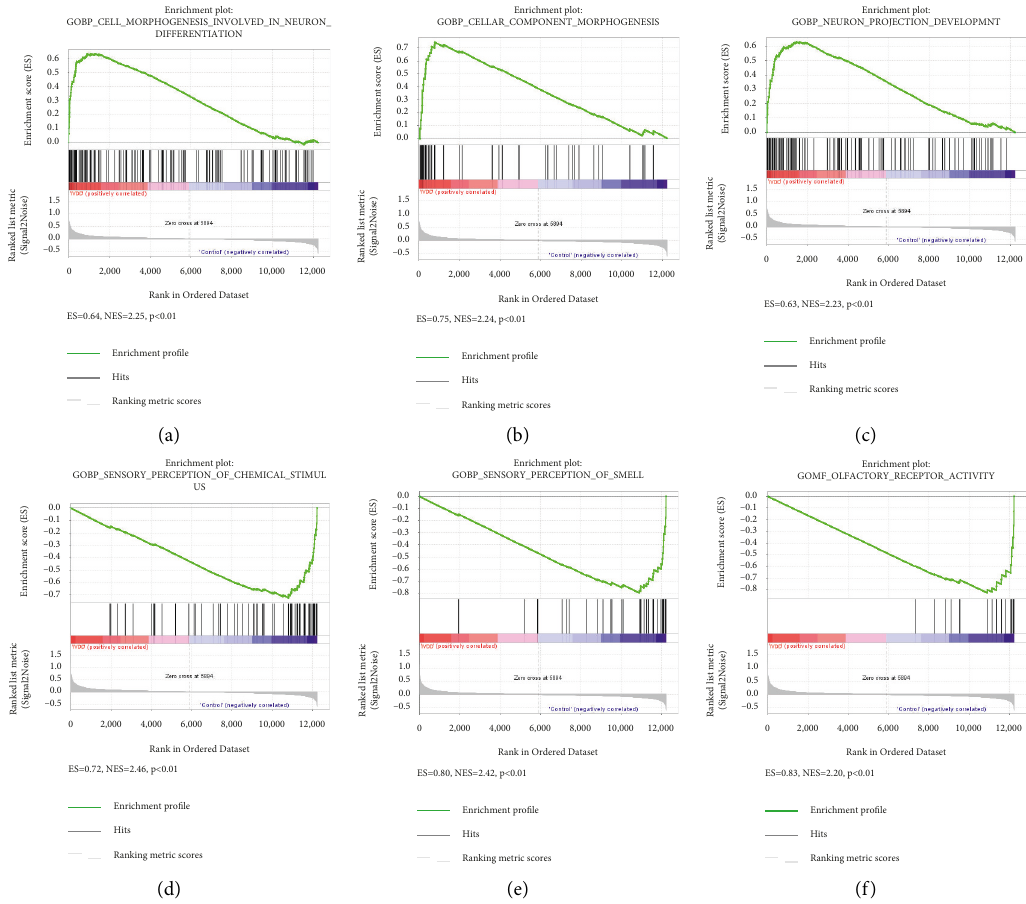
Figure 4: GSEA plots showing the most enriched gene sets of all detected genes in the ROP group and the control group in the GSE158799 dataset. The top 3 most significant upregulated enriched gene sets in the ROP group: (a) positive regulation of vasculature development, (b) establishment of endothelial barrier, and (c) blood vessel endothelial cell migration. The top 3 most significant upregulated enriched gene sets in the control group: (d) sensory perception of chemical stimulus, (e) sensory perception of smell, and (f) olfactory receptor